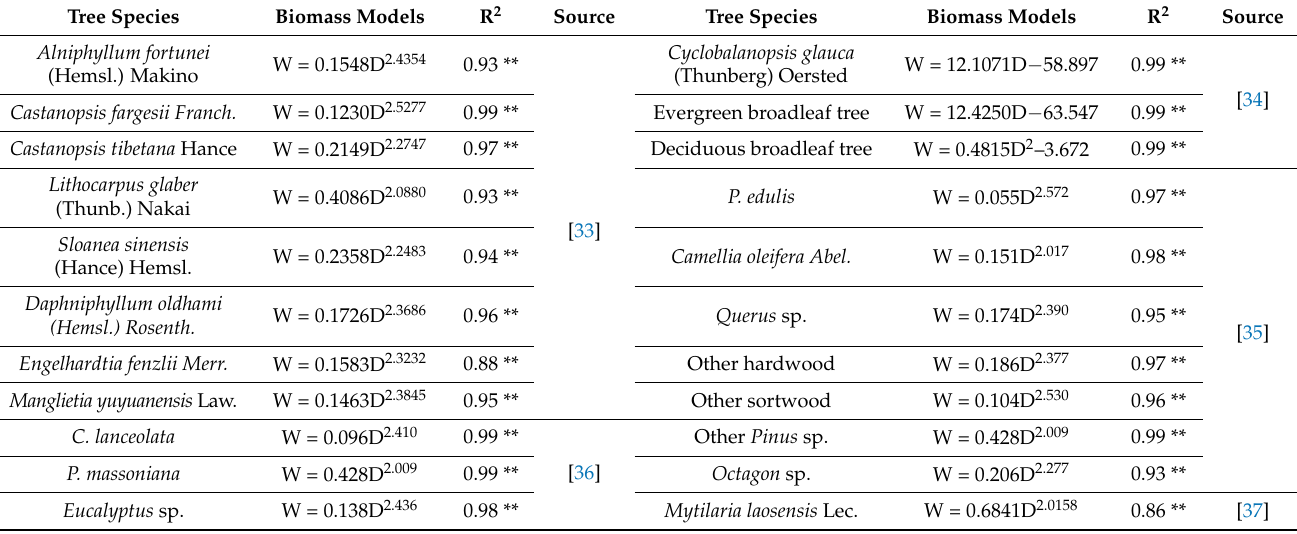
Table 2. Biomass–DBH allometric equations for main tree